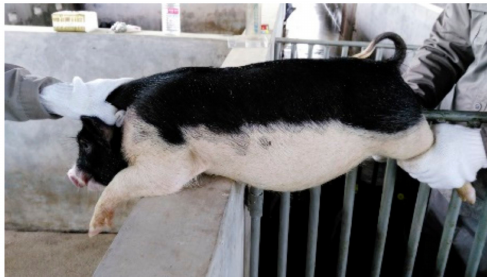
Figure 1. A Wuzhishan pig, showing the characteristic black back and white